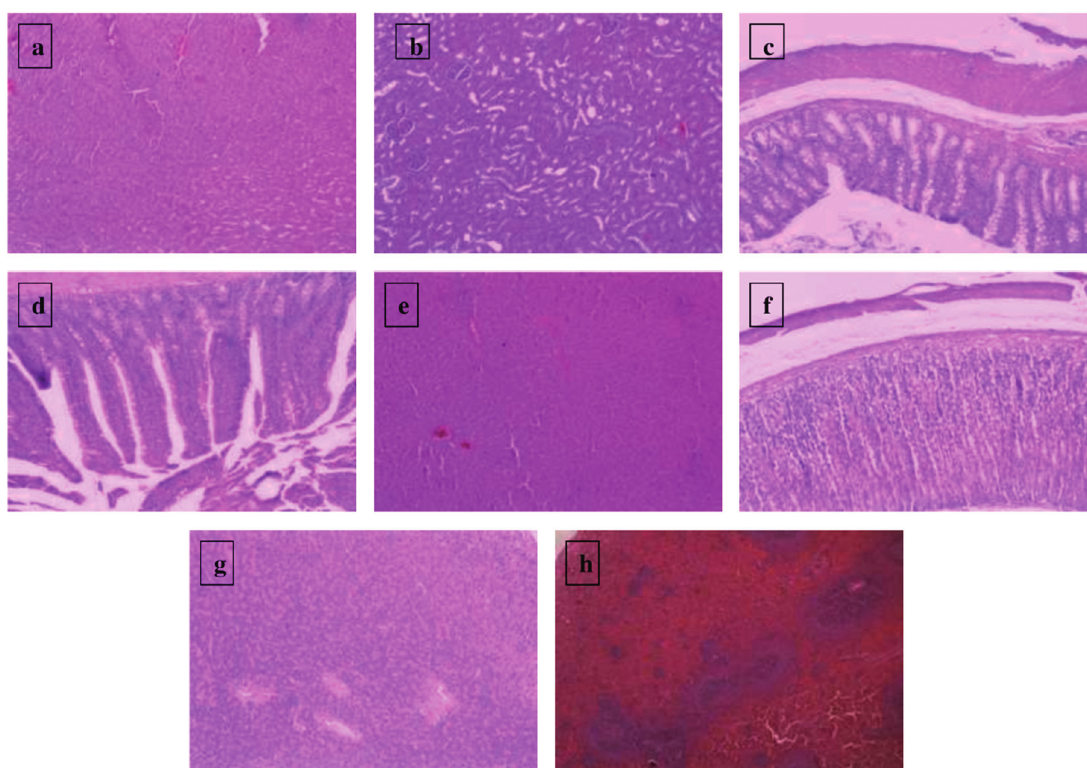
Figure 3: Photomicrographs of different organ systems ((a) heart, (b) kidney, (c) large intestine, (d) small intestine, (e) liver, (f) stomach, (g) pancreas, and (h) spleen) from Sprague Dawley male rats with the higher dose of A. syriaca . No significant histopathological lesions were found (H&E stain,